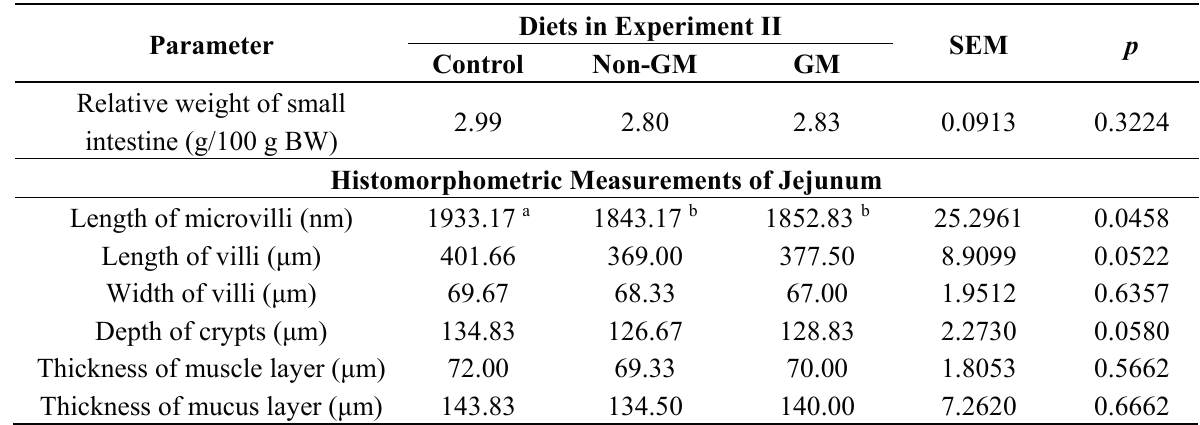
Table 4. Relative weight and results of histomorphometric measurements of the small intestine of rats from Experiment II.